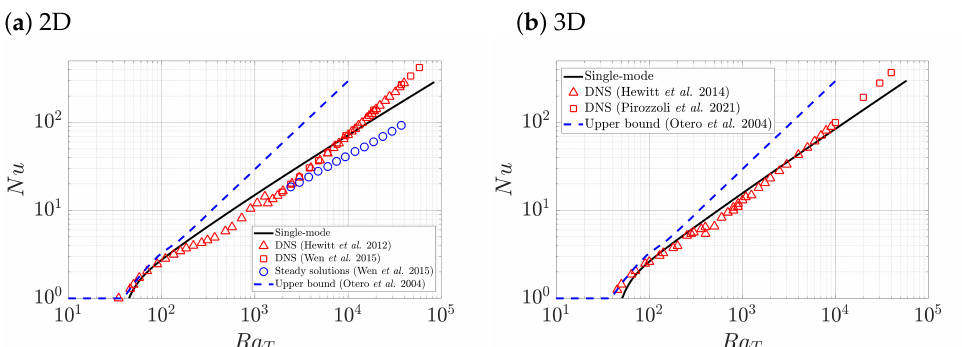
Figure 4. Nu as a function of Ra T from single-mode solutions (black lines). Panel ( a ) shows 2D results with k x = 0.48 Ra 0.4 , k y = 0 compared with DNS data (Figure 2 in [25] and Figure 5b in [26]), T exact 2D steady convection rolls (Figure 5b in [26]), and upper bound theory (Figure 5 in [52]). Panel ( b ) displays 3D results with k x = k y = 0.17 Ra 0.52 compared with DNS data (Figure 2a in [27] and T Table 1 [28]) as well as upper bound theory (Figure 5 in [52]). The single-mode solutions are